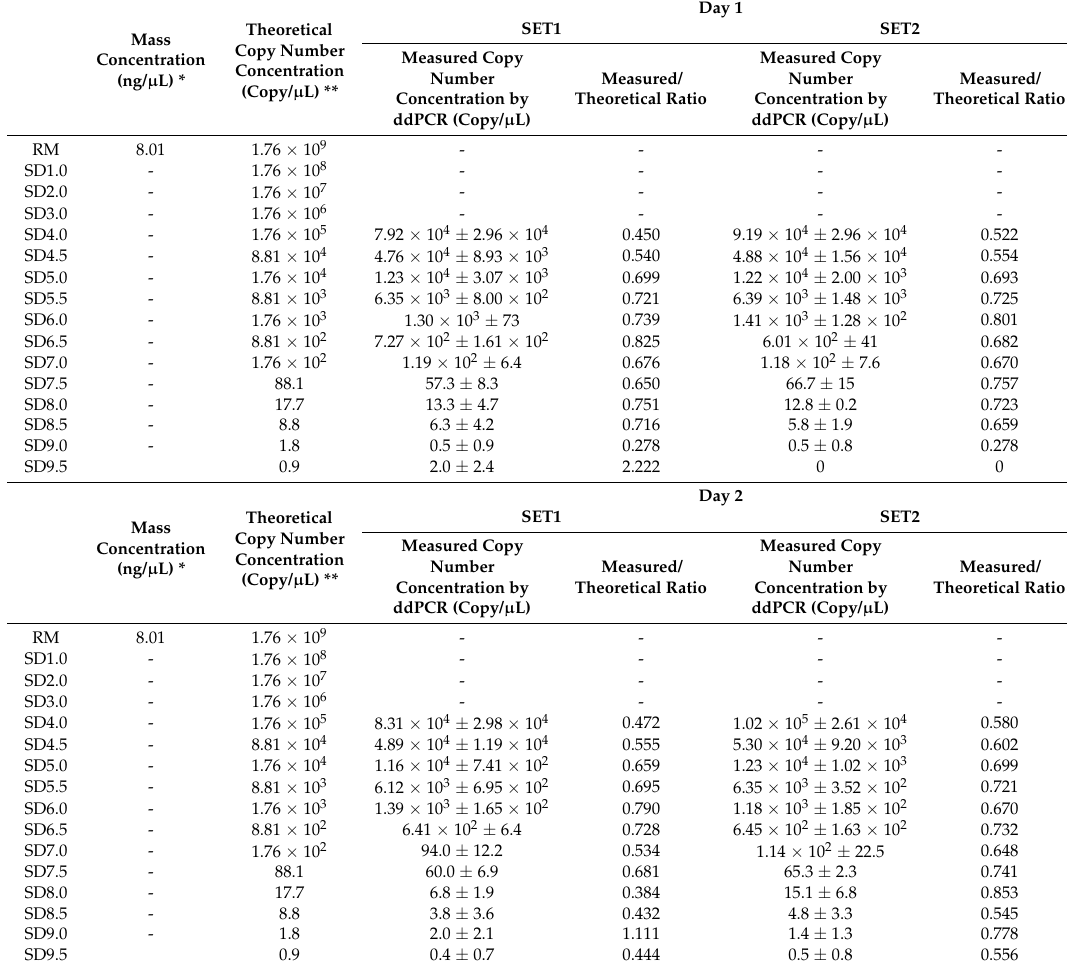
Table 2. Concentrations of reference material (RM) and serially diluted (SD)